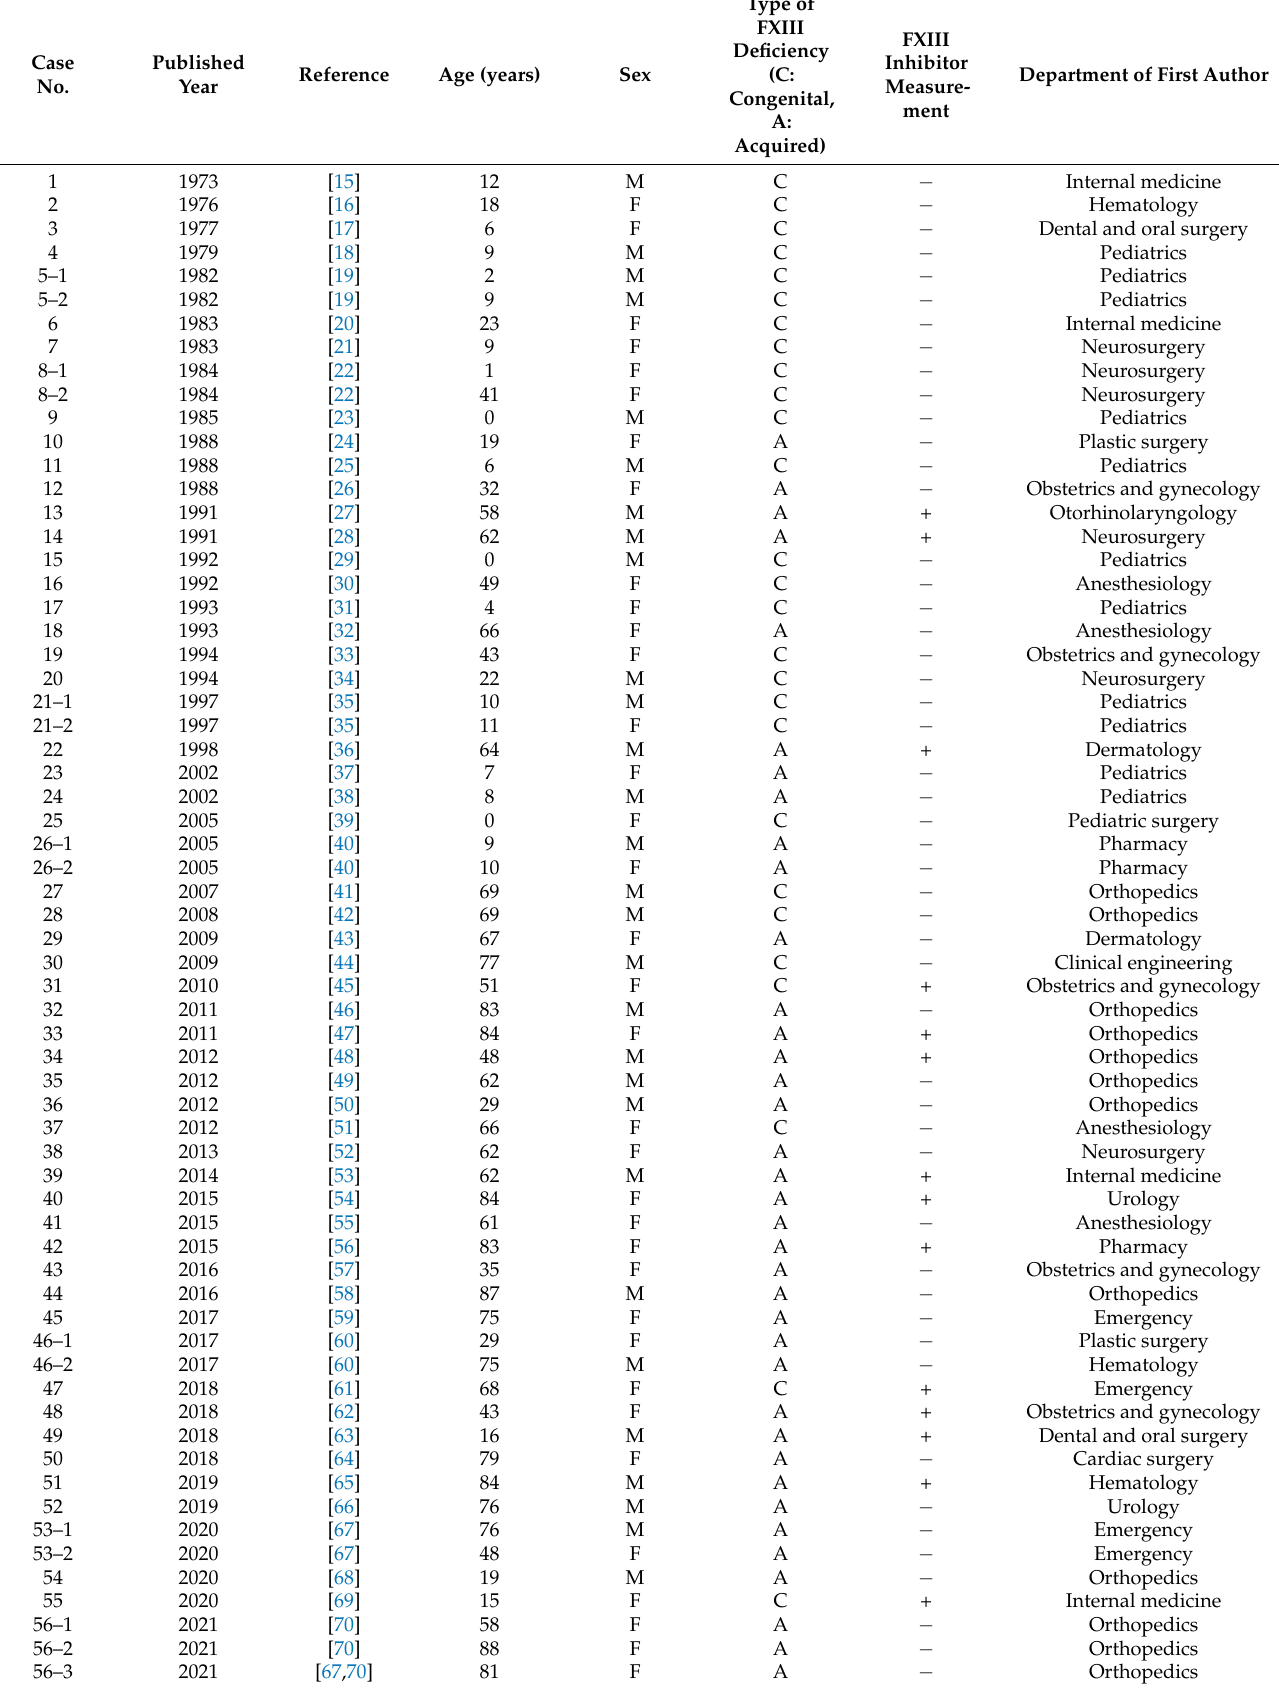
Table 4. Included case reports in this review (56 case reports and case series which included 64